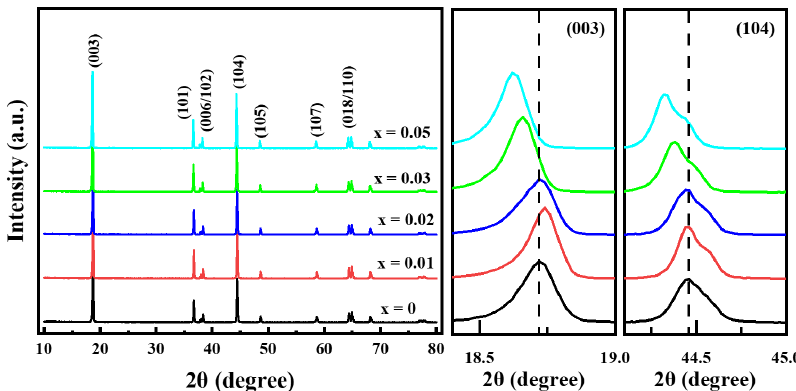
Figure 3. XRD patterns of Li[Ni 0.6 Co 0.2 Mn 0.2 ] 1 − x Ga x O 2 samples.